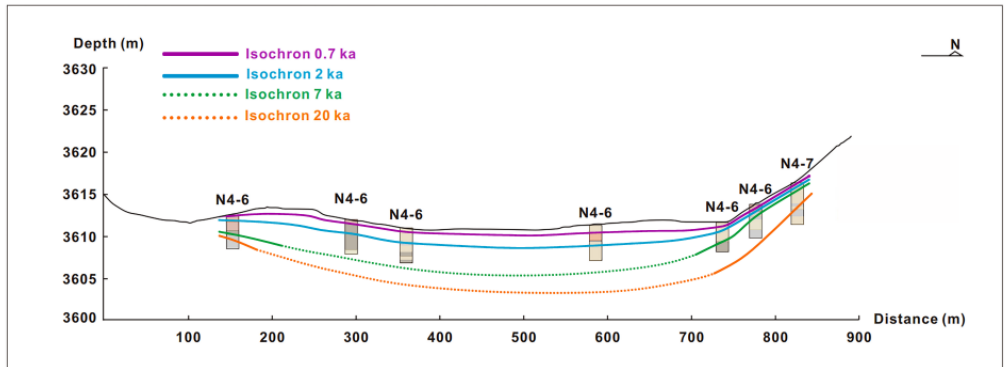
Figure 10. Historical morphological recovery for the N4 cross-section.